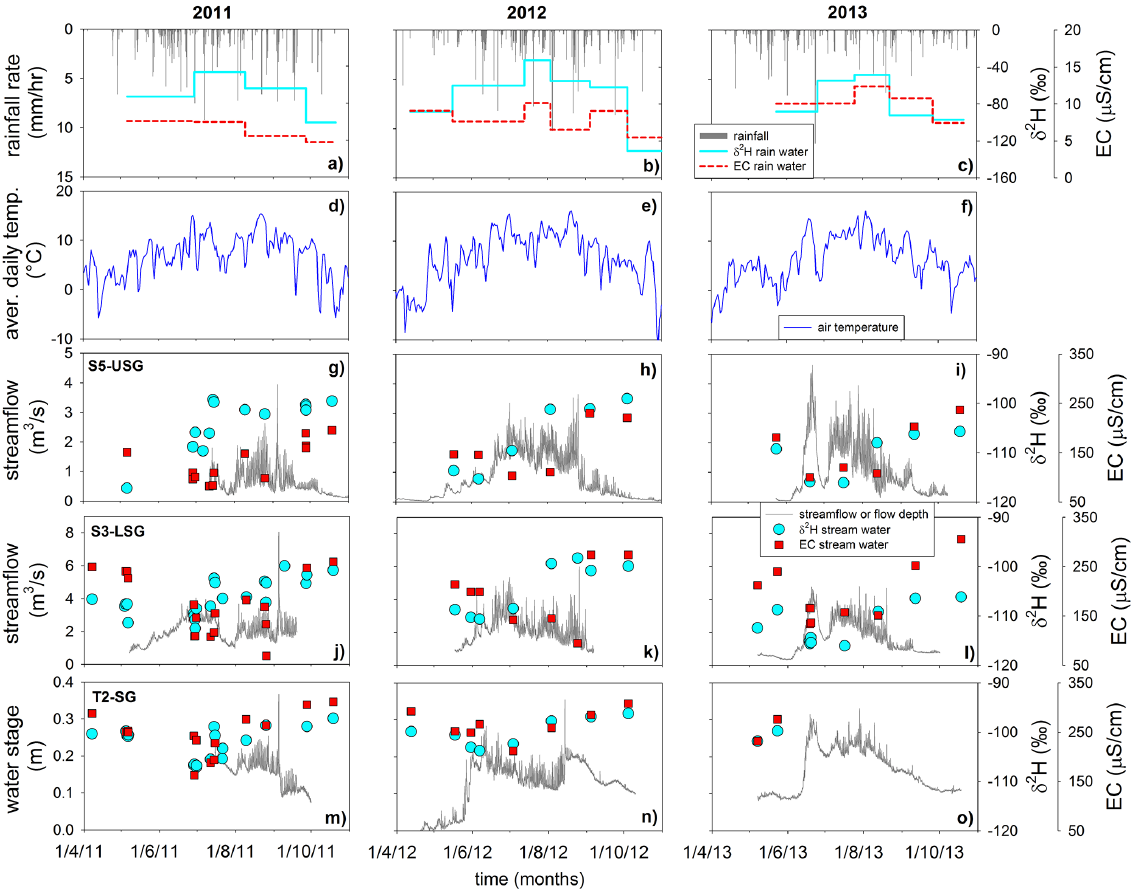
Figure 6. Top row panels ( a – c ): hourly time series of precipitation (average of values from M3 and M4), and δ 2 H and EC in bulk precipitation (average of values from RF2, RF3 and RF4). Second row panels ( d – f ): daily average temperature (average of values from M3 and M4). Middle row panels ( g – i ): hourly time series of streamflow at S5-USG, and δ 2 H and EC of stream water. Fourth row panels ( j – l ): hourly time series of streamflow at S3-LSG, and δ 2 H and EC of stream water. Bottom row panels ( m – o ): hourly time series of water height at T2-SG, and δ 2 H and EC of stream water. On five occasions in 2011 multiple samples were taken within 1 day at S3-LSG; only samples taken in the morning, at peak flow and before sunset are shown in (j) – (l) . All panels refer to the period between 1 April and 31 October, when the majority of water samples was